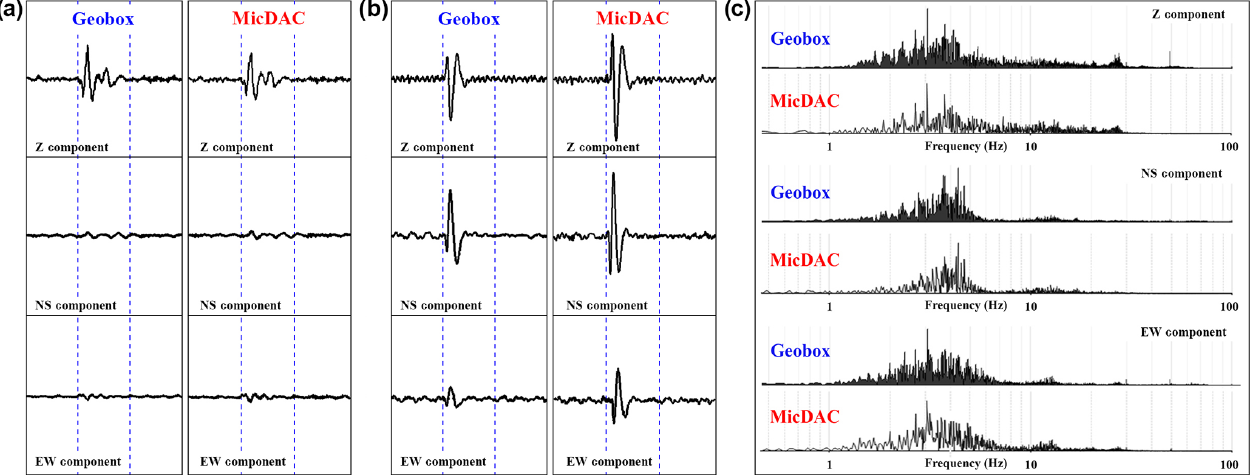
Figure 8. Three-component seismic data recorded simultaneously using both devices: (a) MicDAC with 46dB gain and (b) MicDAC with 60dB gain. (c) Comparison of Fourier spectra of recorded three-component microtremor data using GeoBox and